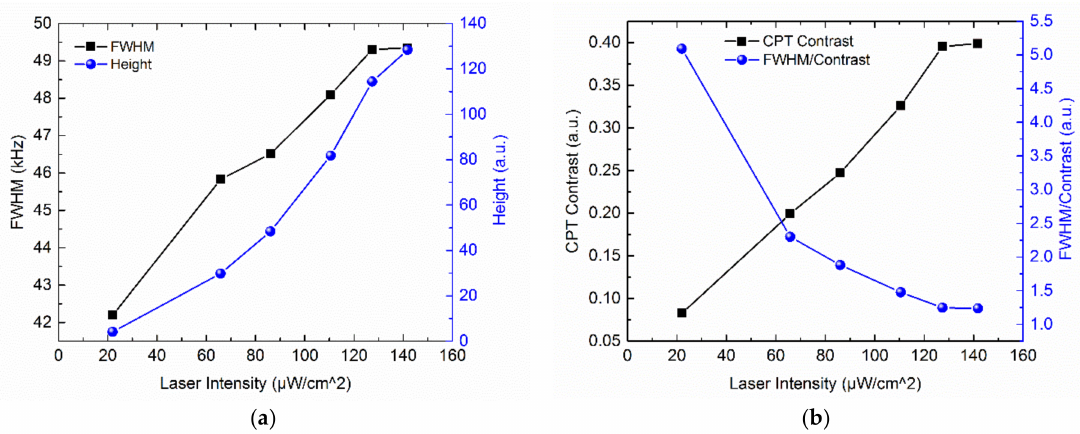
Figure 13. Measured ( a ) Full Width at Half Maximum (FWHM), height; ( b ) CPT signal contrast and FWHM/Contrast of the (0,0) CPT signal as a function of laser intensity for the microfabricated vapor